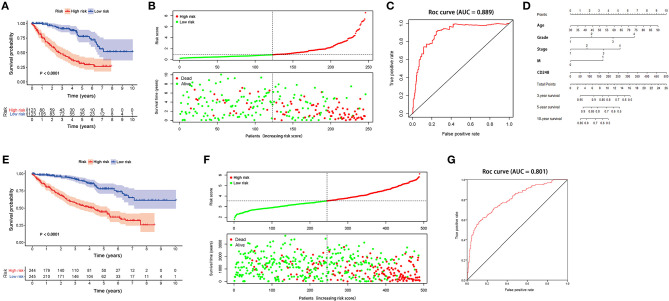
The prognostic value of CD248-based signature (A) The Kaplan–Meier curve of a training cohort (B) The distribution of the risk score and the survival status of each patient in the training cohort (C) The ROC curve of the present signature in the training cohort (D) A nomogram of the present signature (E) The Kaplan–Meier curve of the testing cohort (F) The distribution of the risk score and the survival status of each patient in the testing cohort (G) The ROC curve of the present signature in the testing cohort. Ninety-five percent confidence interval is shown as light-colored background. p < 0.05 was considered statistically significant.